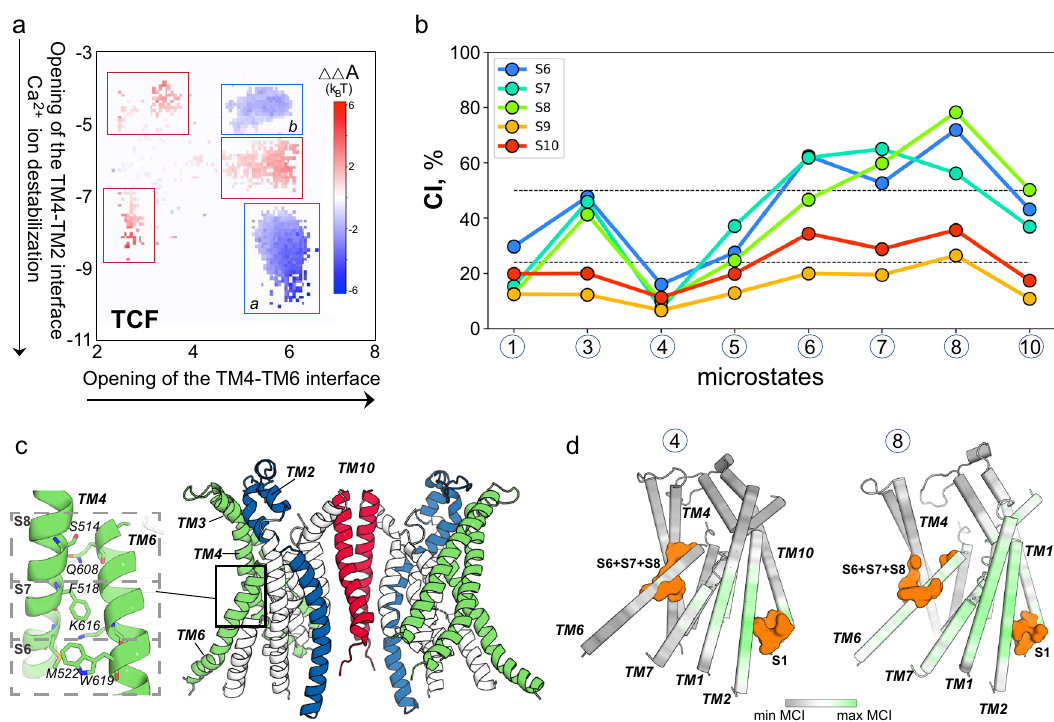
Fig. 5 Allosteric coupling between the distal Ca 2 + binding site and the groove region of mTMEM16F. a The 2D tICA space from Fig. 3 is shown colored according to the TCF. The regions that are stabilized by allosteric coupling between tIC1 and tIC2 vectors ( ΔΔ A ( x, y ) < 0) are highlighted by blue rectangles and labeled as a and b , and the regions that are destabilized by such coupling (( ΔΔ A ( x, y ) > 0) are marked by red rectangles. b A plot of the CI values calculated between the transmitter S1 site (non-hydrogen atoms of the four Ca 2 + coordinating residues: D395, S854, I857, D859) and several receiver sites at the TM4-TM6 interface (S6 site – non-hydrogen atoms of M522-W619 pair of residues; S7 site – non-hydrogen atoms of F518-K616 pair of residues; S8 site – non-hydrogen atoms of S514-Q608 pair of residues), calculated in the trajectories representing the indicated microstates (see also Fig. S13). The two horizontal lines demarcate regions of low, average, and high levels of coordination as obtained from the clustering of the CI data using the Fisher-Jenks algorithm (see “ Methods ” ). c The mTMEM16F dimer structure highlighting the location and composition of the S6, S7, and S8 sites used in the calculations of CI shown in b . d The mTMEM16F monomer structure colored according to the normalized MCI values between the S1 site and the structural locus comprised of the residues from S6, S7, and S8 sites calculated for microstate 4 (left) and 8 (right) trajectories. The residue atoms at S1 and S6 + S7 + S8 sites are shown as orange